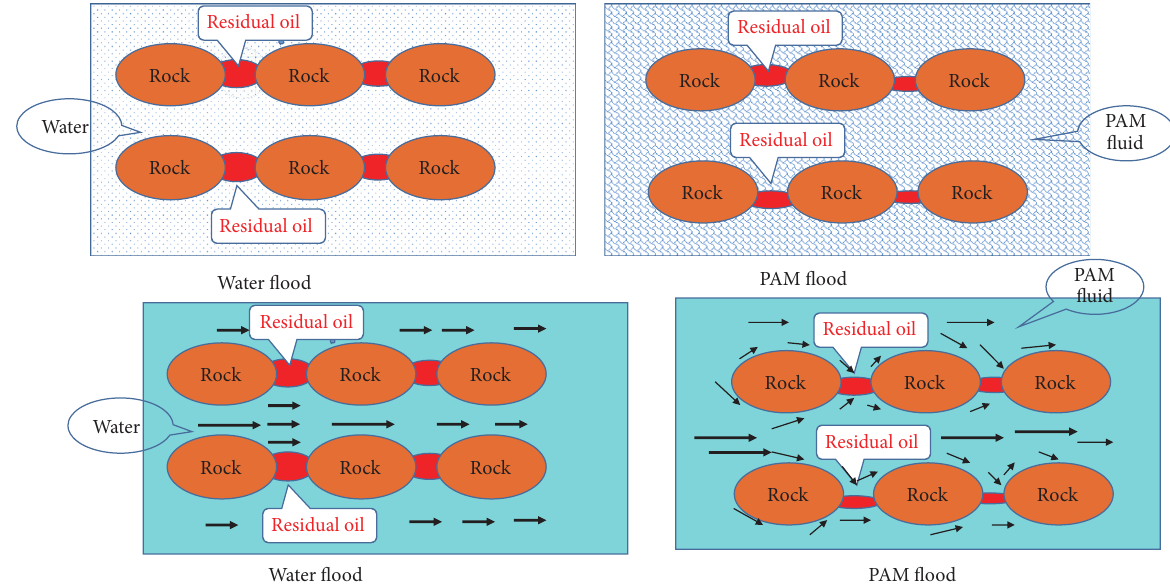
Figure 2: Influence of viscoelasticity on displacement efficiency